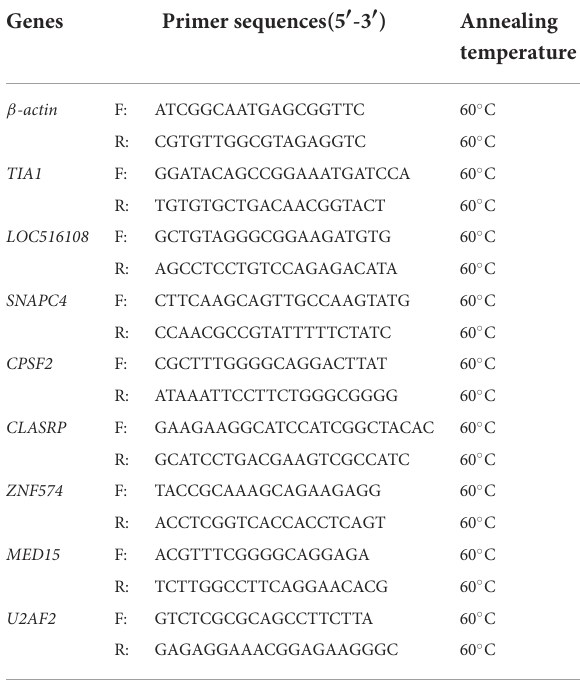
TABLE 1 The hub genes’ quantitative PCR primer